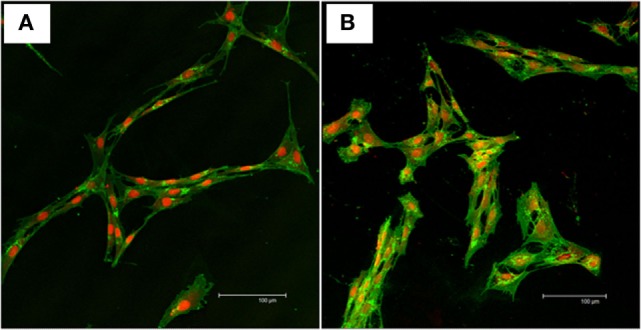
Nuclear/cytoplasmic staining of mesenchymal stem cells. Representative confocal images of WGA (green) and TOPRO-3-iodide (red) fluorescent stains showing the viability and morphology of the cells. (A) Typical fibroblast-like morphology of undifferentiated bone marrow-derived mesenchymal stem cells. (B) Typical fibroblast-like morphology of undifferentiated synovial fluid-derived mesenchymal stem cells. Scale bar = 100 µm.